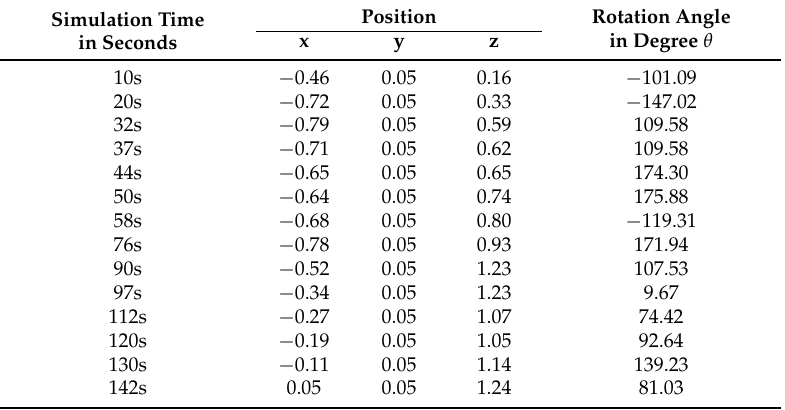
Figure 24. Average of distance traveled by the robot’s differential wheels. Table 7. Summaries of the robot’s position and rotation angle at various simulation